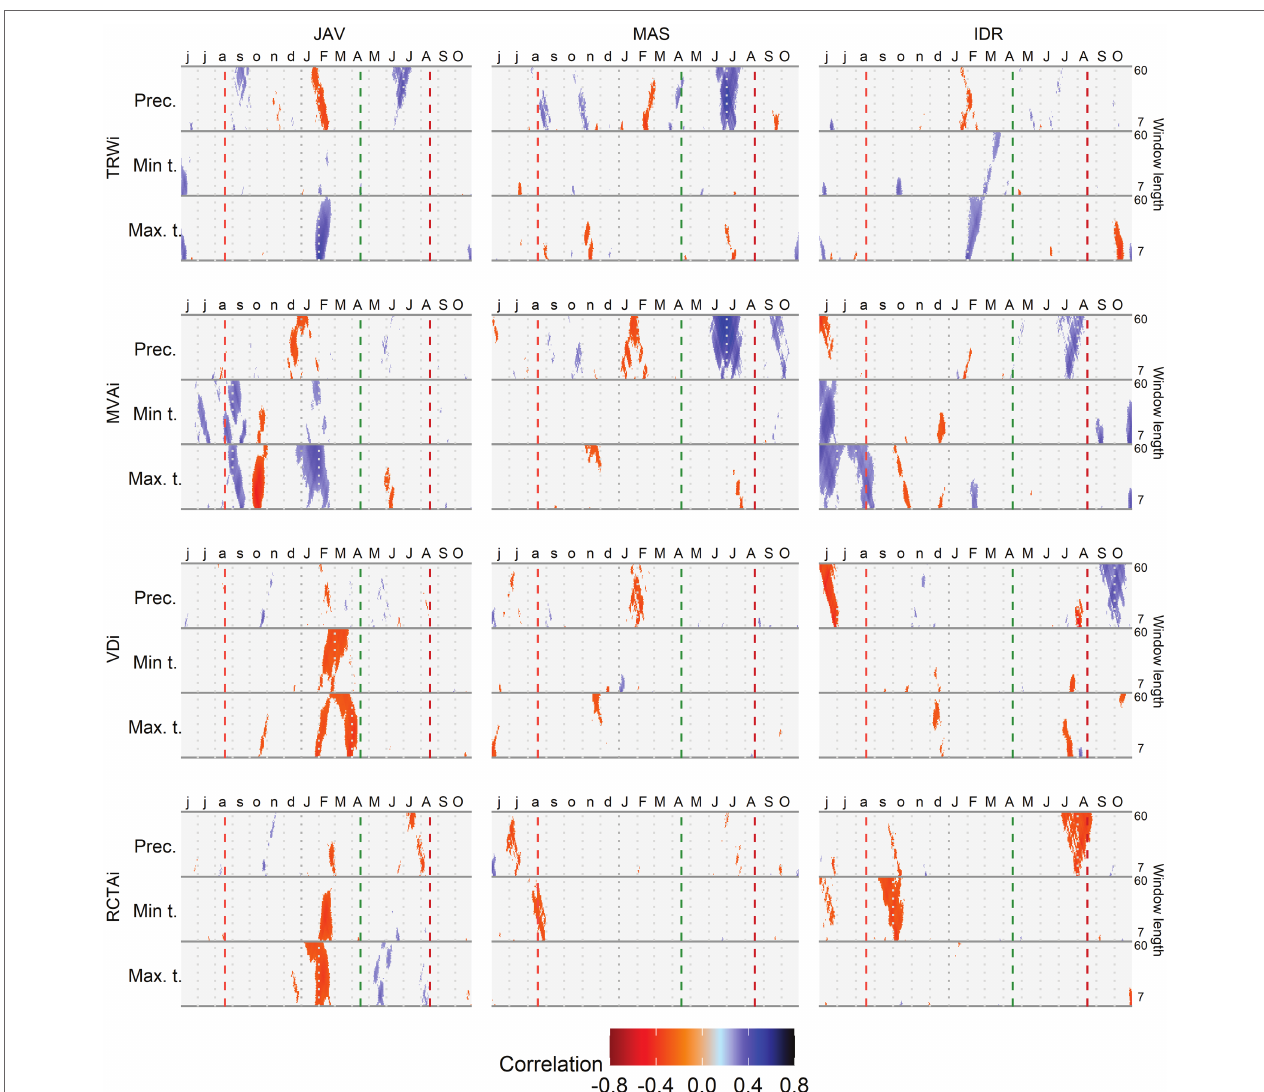
FIGURE 5 | Correlations between standardized tree-ring chronologies (tree ring width - TRWi, mean vessel area - MVAi, vessel density - VDi and relative conductive area - RCTAi) and maximum and minimum daily temperature and daily precipitation sums at Javornik (JAV), Mašun (MAS) and Idrija (IDR) using a time window spanning between 7 and 60 days. Vertical dashed lines from left to right depict the approximate timing of the growing season based on previous data (Prislan et al., 2013): end of previous growing season (light red), start (green), and end (dark red) of current growing